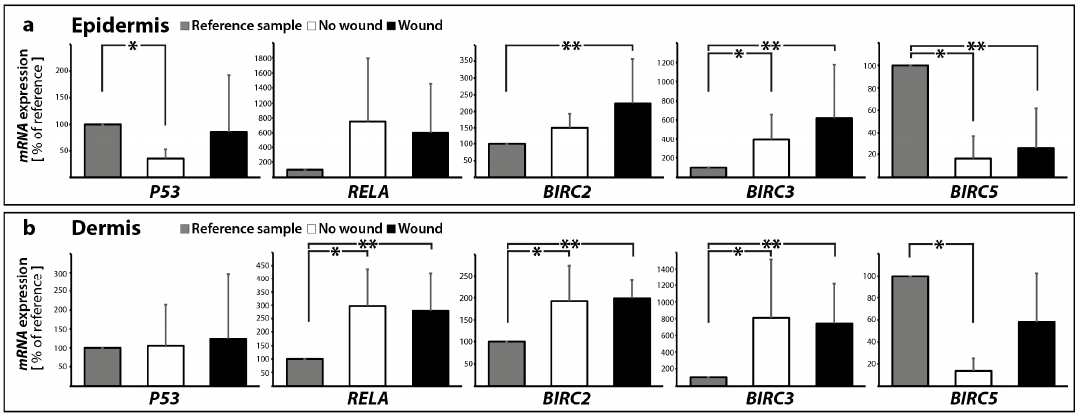
Figure 8. Quantitative real-time PCR of P53 , RELA , BIRC2 , BIRC3 and BIRC5 performed for epidermis ( a ) and dermis ( b ) samples; * p < 0.05 reference vs. no wound, ** p < 0.05 reference vs. wound.